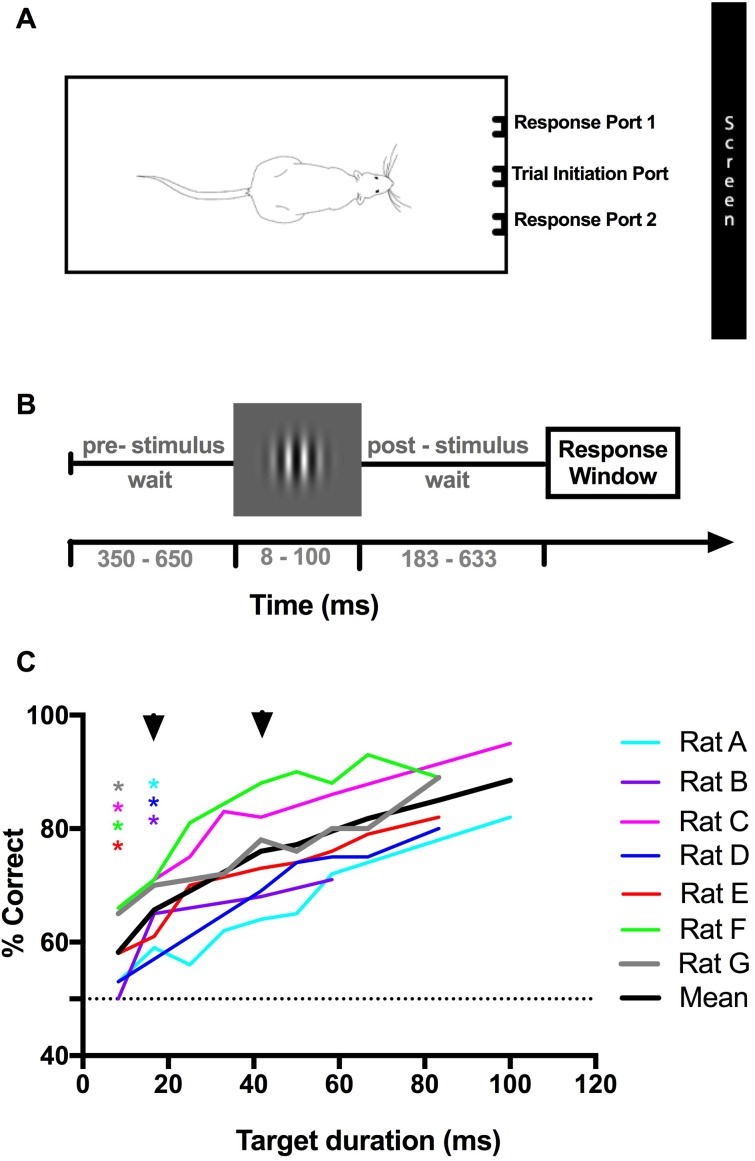
Rat orientation discrimination performance increases with target stimulus duration.(A) The testing chamber is fitted with three photo-interrupter detectors; a central sensor for trial initiation and two flanking sensors equipped with drinking spouts for perceptual report. The rat activates each sensor by breaking the infrared beam with its nose. Trial initiation results in the presentation of visual stimuli on an LCD monitor placed at a 25 cm viewing distance. When the rat selects the correct response port, a liquid reward is delivered at the centre of the corresponding flanking sensor. (B) Trial structure. Rat performance was measured in the absence of a mask across varying target durations. Following a central nose-poke, a blank gray screen was shown for a random period of 350–650 ms. Subsequently, the target grating was visible for 8.3–100 ms, followed by another random period with blank screen. After this period, a tone sounded, signalling that animals could leave the central port and move to a side port to indicate their response. Correct responses were only rewarded if they were made in the allocated response window. (C) Individual and average performance across 7 animals. The dotted line indicates chance performance. For each rat, the target duration where performance became significantly above chance is indicated by an asterisk (*, p<0.05). The black arrows indicate the target duration (16 and 42 ms) selected for subsequent masking experiments. For rat A, data represents a summary of performance across an average of 155 trials/duration and 17 sessions (Rat B– 214 trials/duration; 9 sessions. Rat C– 298 trials/duration; 24 sessions. Rat D– 327 trials/duration; 23 sessions. Rat E– 381 trials/duration; 25 sessions. Rat F– 191 trials/duration; 9 sessions. Rat G– 226 trials/duration; 29 sessions).